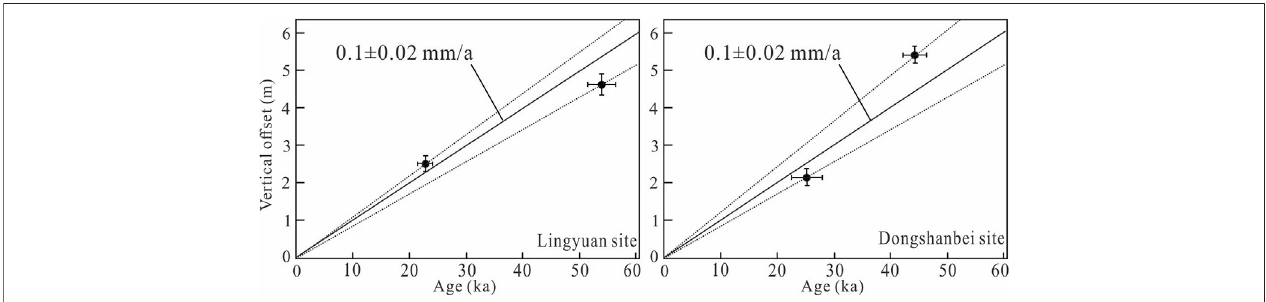
FIGURE9| AverageverticalslipratesontheZWPF,whichareestimatedfromverticaloffsetsrecordedbyterracesT2and T3attheLingyuansiteand T2andT4at the Dongshanbei site and their corresponding abandonment ages.